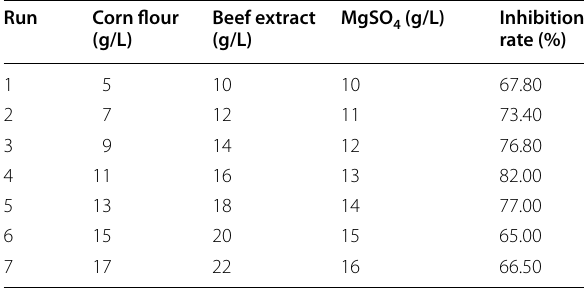
Table 3 Experimental design and response of the steepest ascent test Run Corn flour